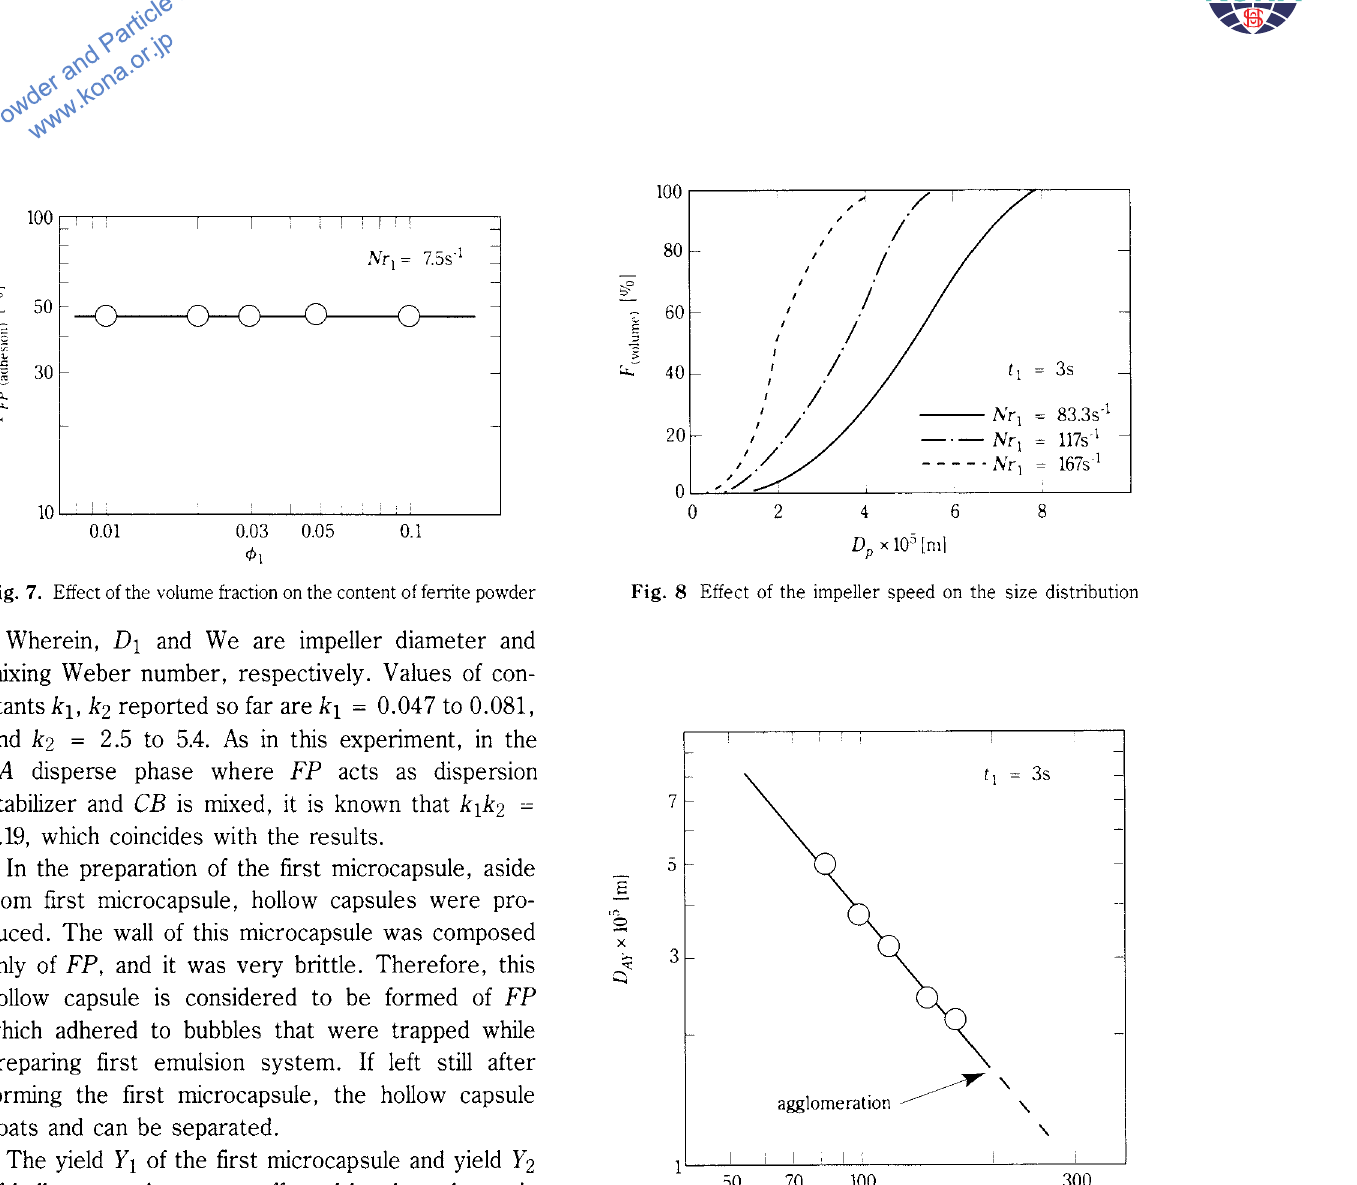
Fig. 9 Effect of the impeller speed on the mean size